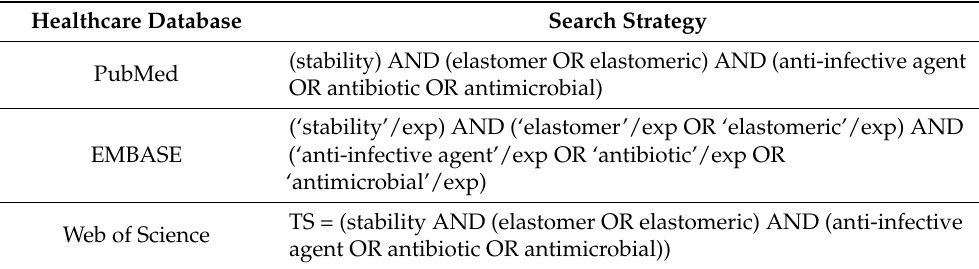
Table 9. Complete search strategy for different